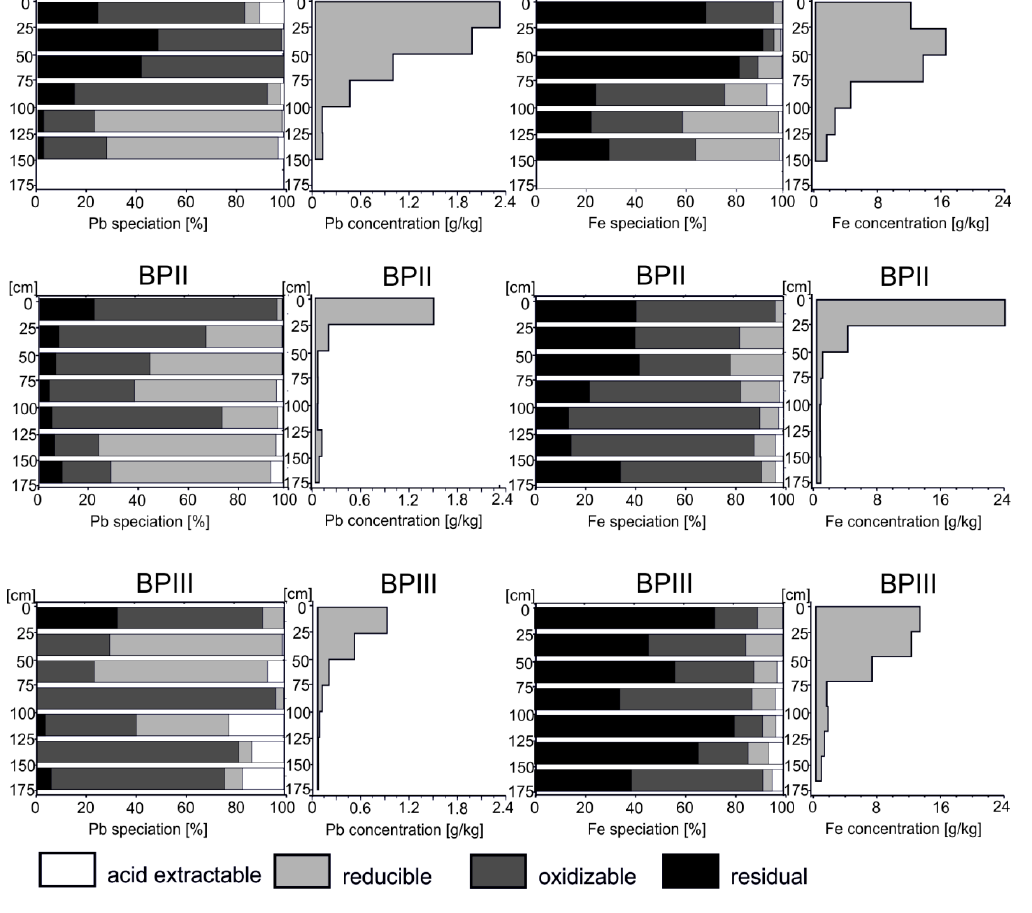
Figure 8. Pb and Fe content and speciation in the Bia ł a Przemsza River sediments.